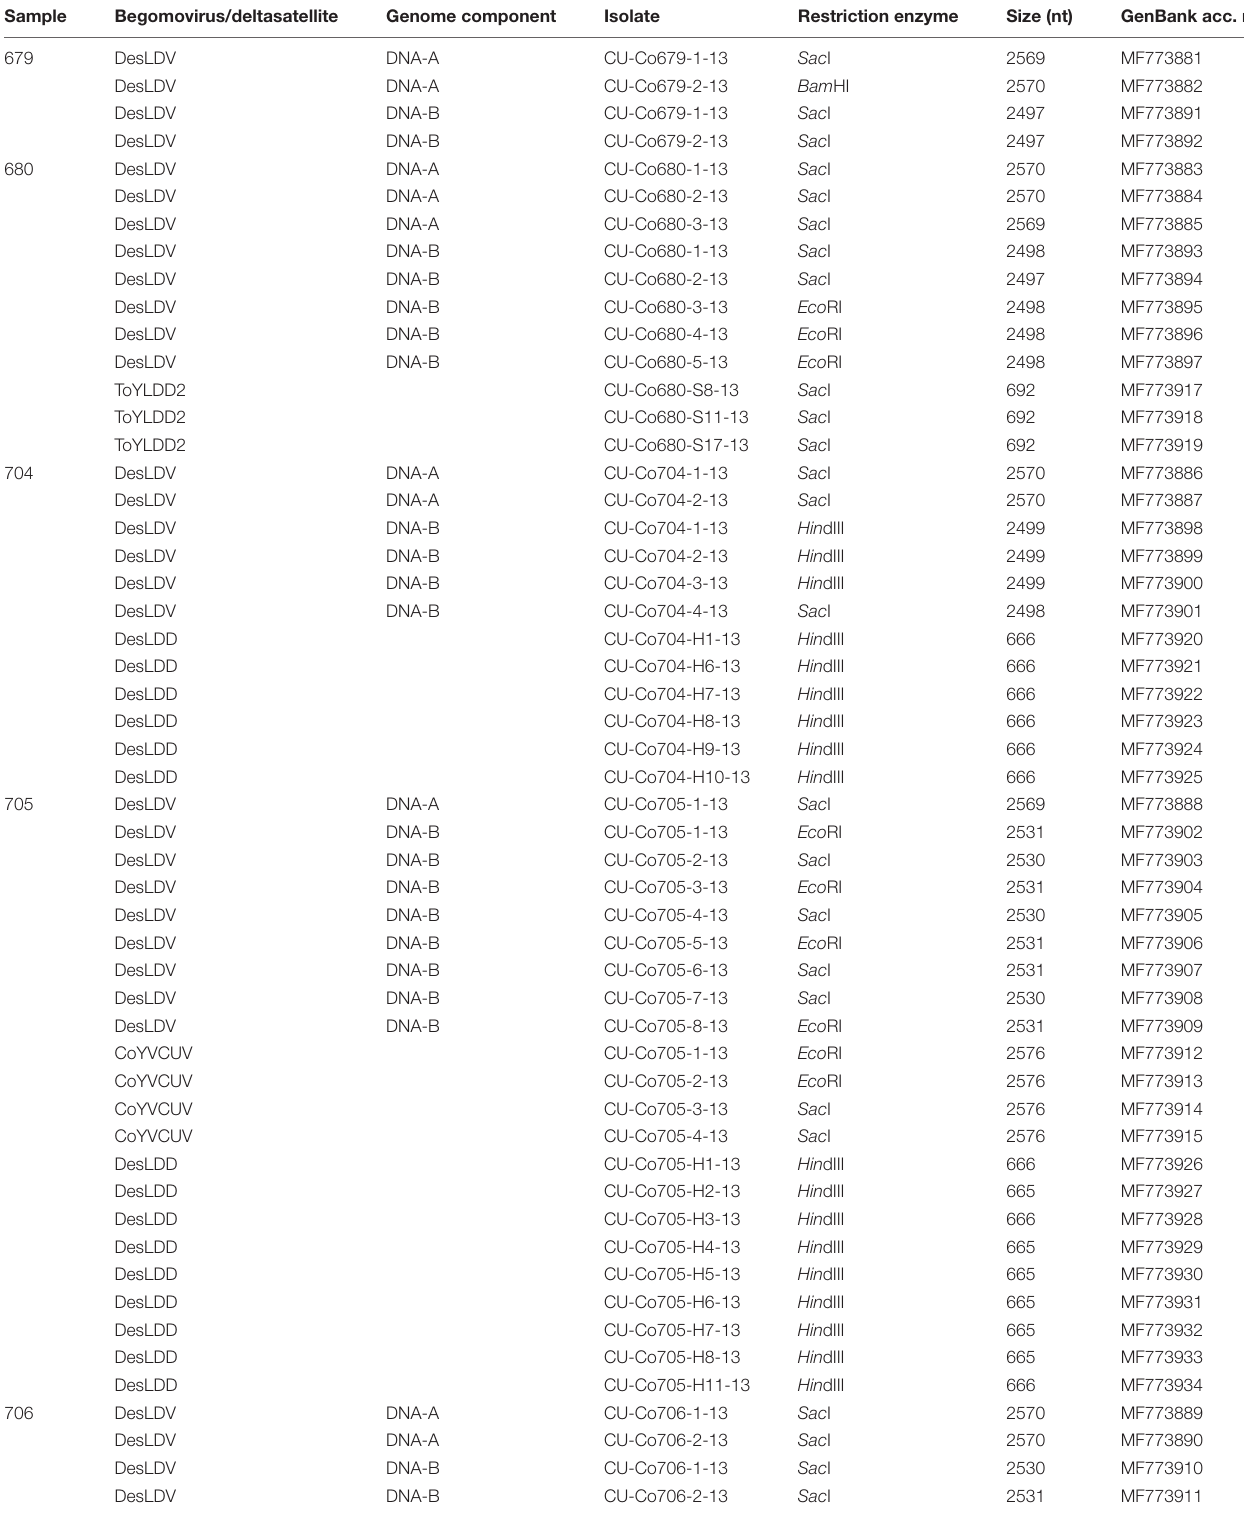
TABLE 2 | Begomoviruses and deltasatellites isolated from Corchorus siliquosus plants showing yellow vein symptoms sampled in the province of Matanzas, Cuba.